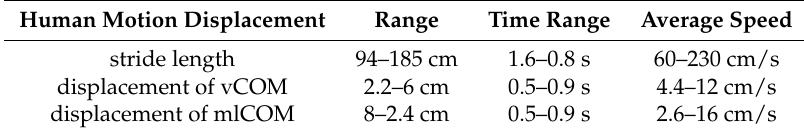
Table 1. Kinematic restrictions of the spatial gait parameters (displacements) of